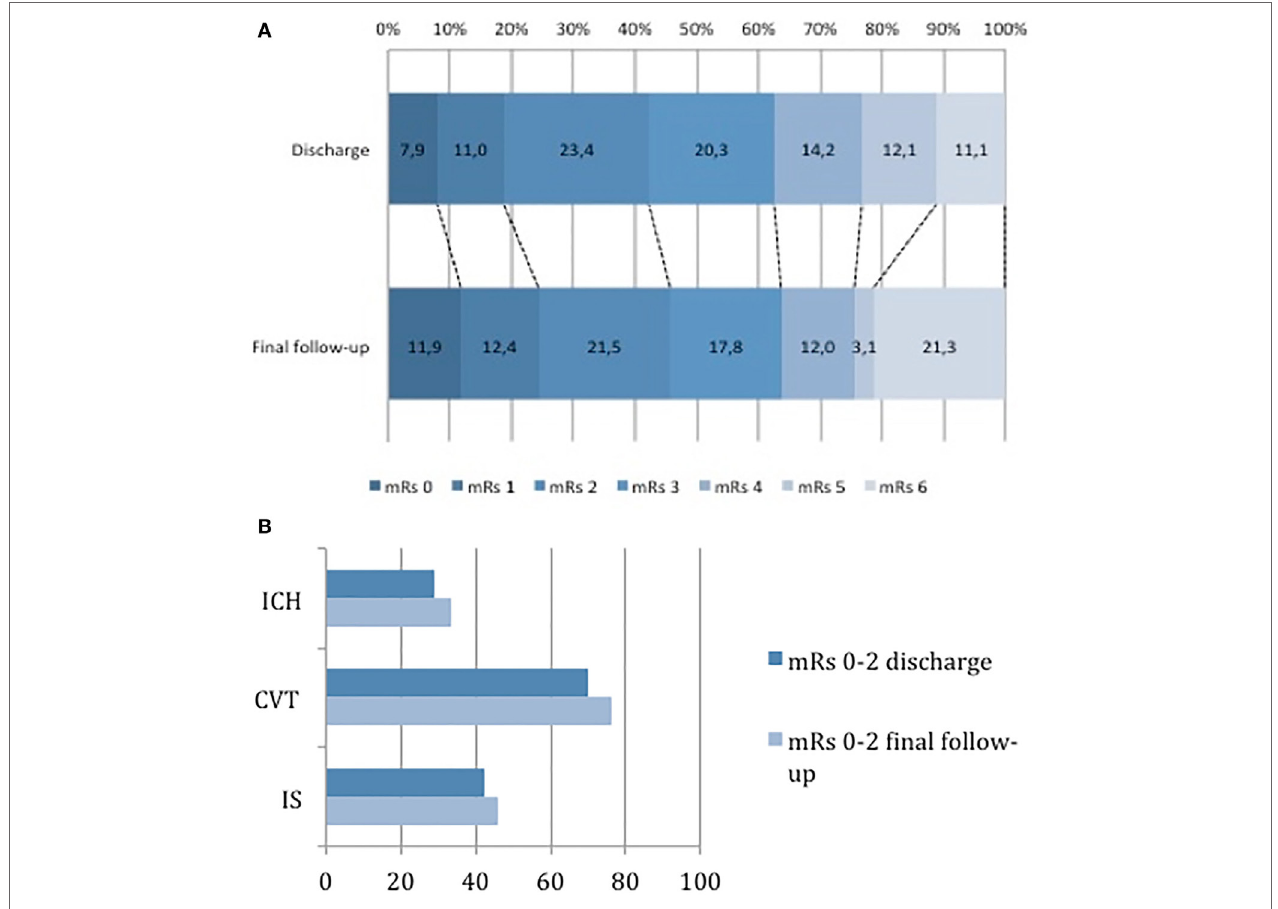
FigUre 1 | Functional outcome as measured by the modified Rankin scale in all patients (a) , and by stroke subtype (B) . Abbreviations: mRs, modified Rankin score; ICH, intracranial hemorrhage; CVT, cerebral venous thrombosis; IS, ischemic